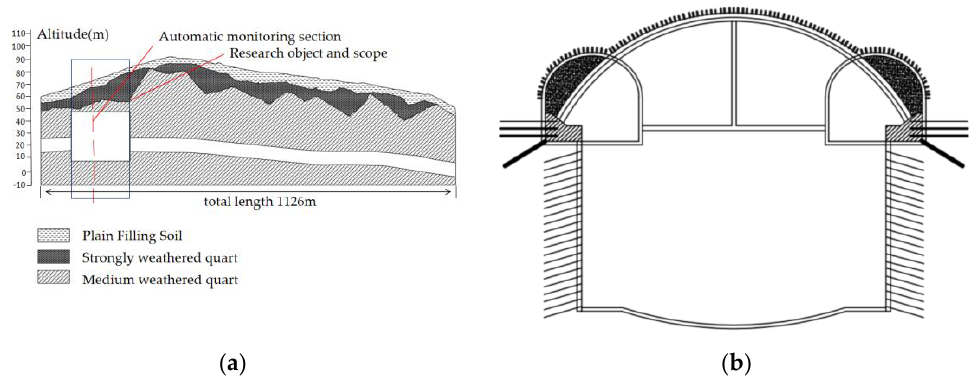
Figure 3. The longitudinal geological profile and the station cross-section: ( a ) the longitudinal geological profile; ( b ) the station cross-section.